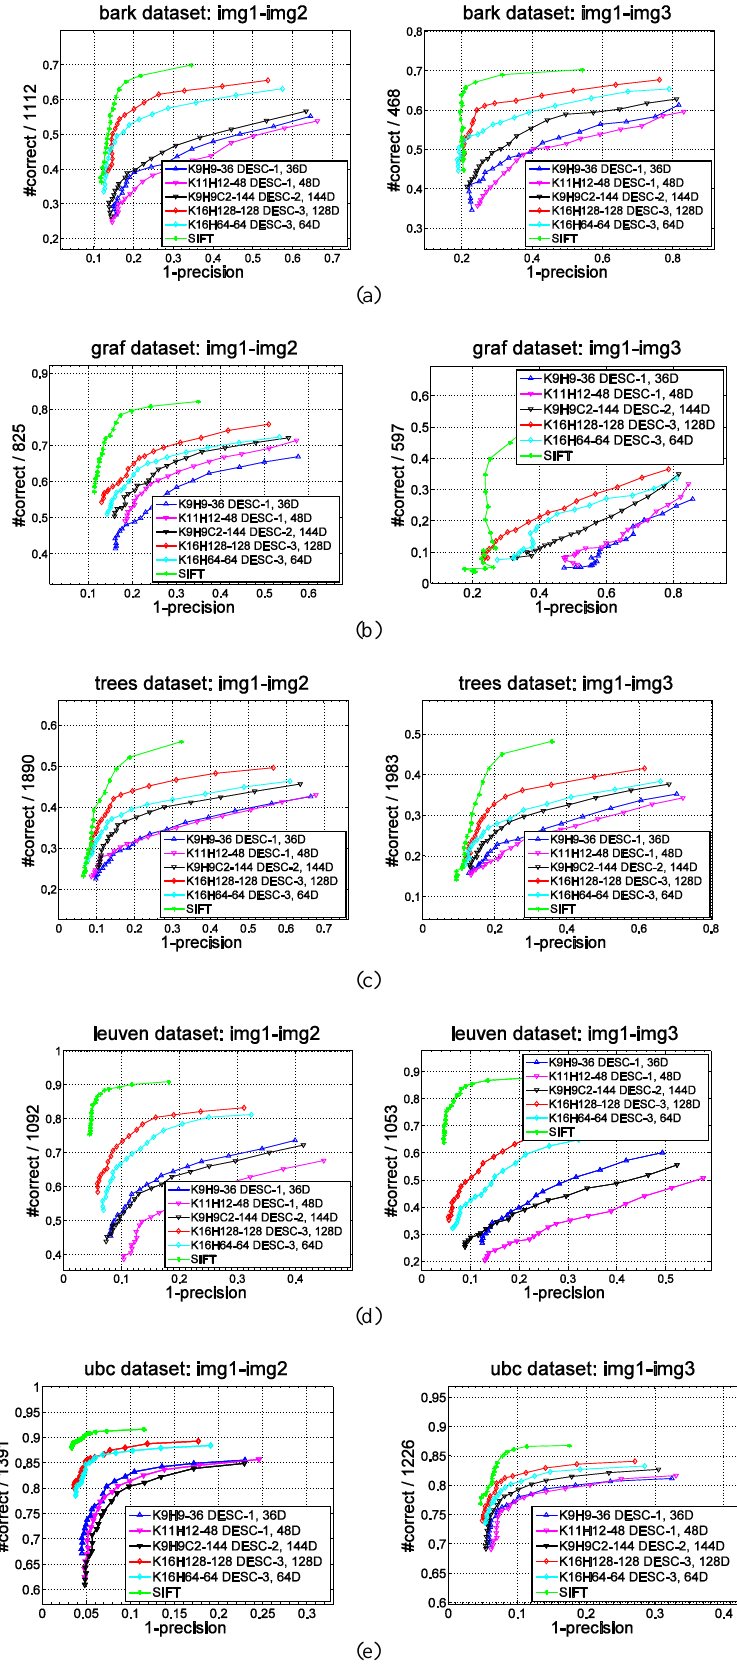
Figure 8. Performance curves of different descriptors under different types of transformations. (a) zoom + rotation. (b) viewpoint change. (c) image blur. (d) light change. (e) JPEG